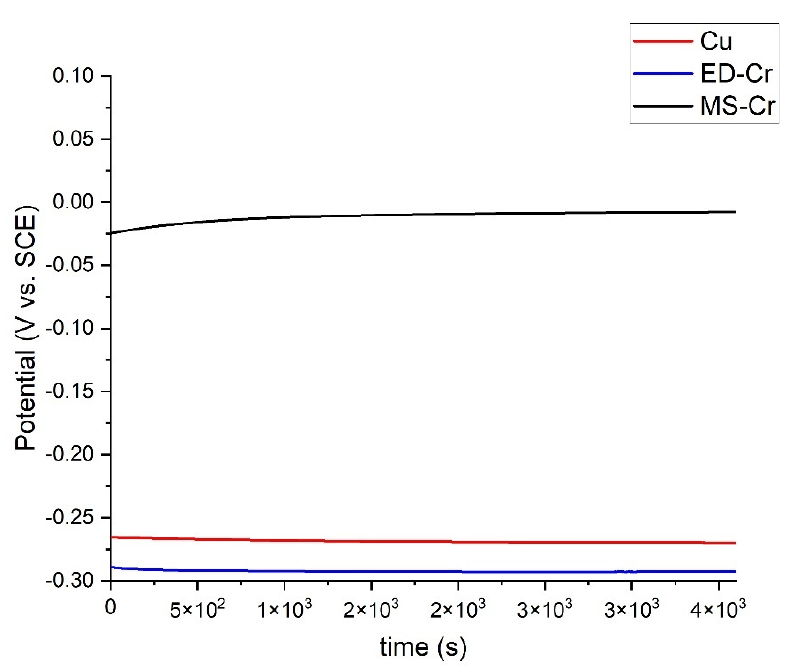
Figure 5. Open circuit potential curves (OCPs) of ED-Cr and MS-Cr coatings compared with the bare Cu in aerated 3.5% NaCl solution as a function of time.